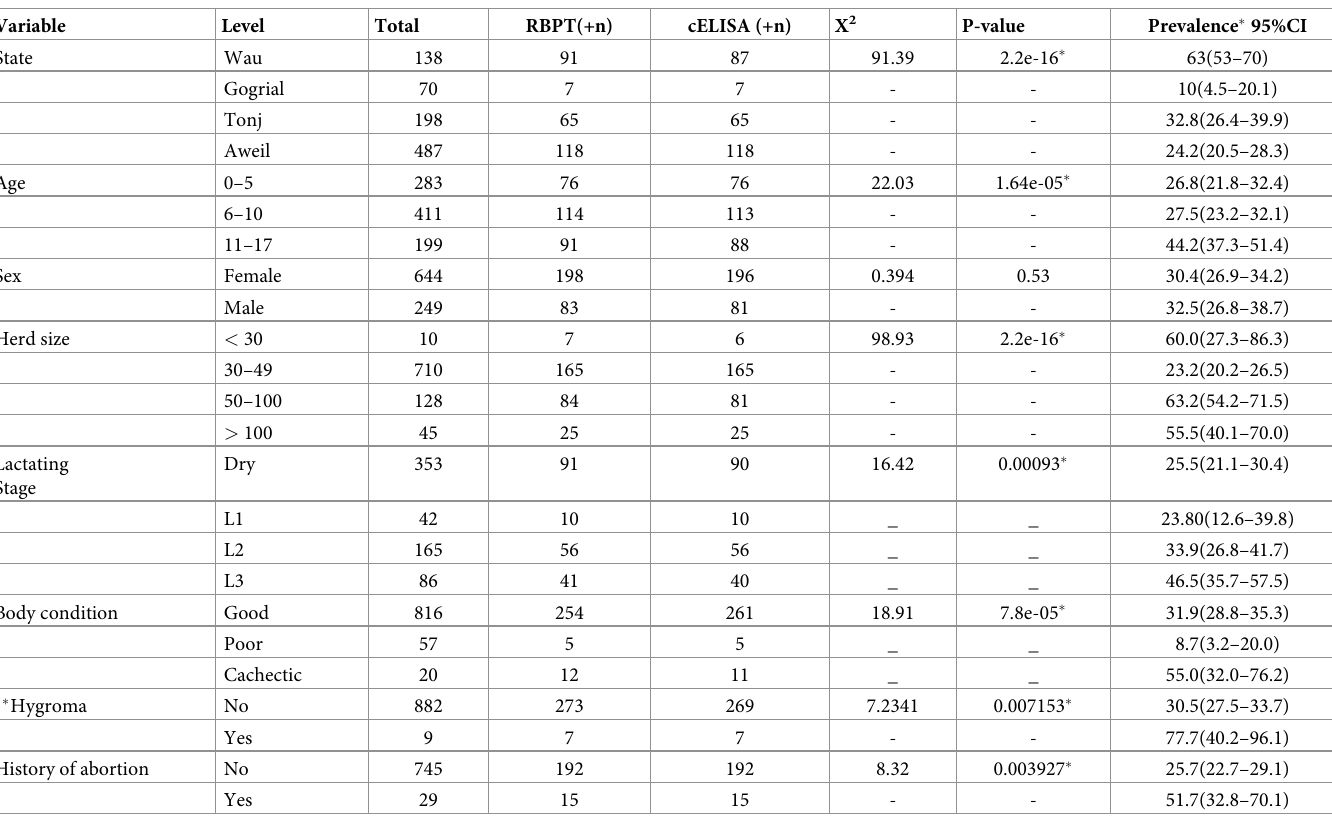
Table 1. Shows the summary statistics for bovine brucellosis, sero-prevalence estimates and a univariable analysis of social demographic factors in Bahr el Ghazal.